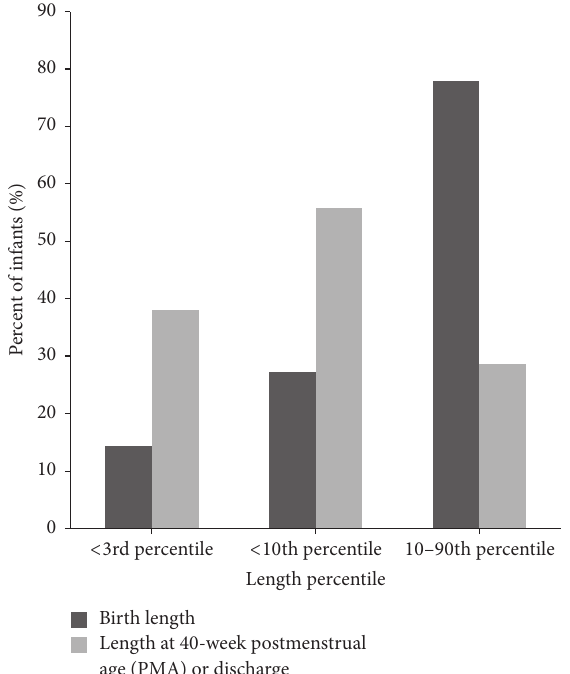
Figure 4: Head circumference percentile ranking from birth to 40- week postmenstrual age (PMA) or